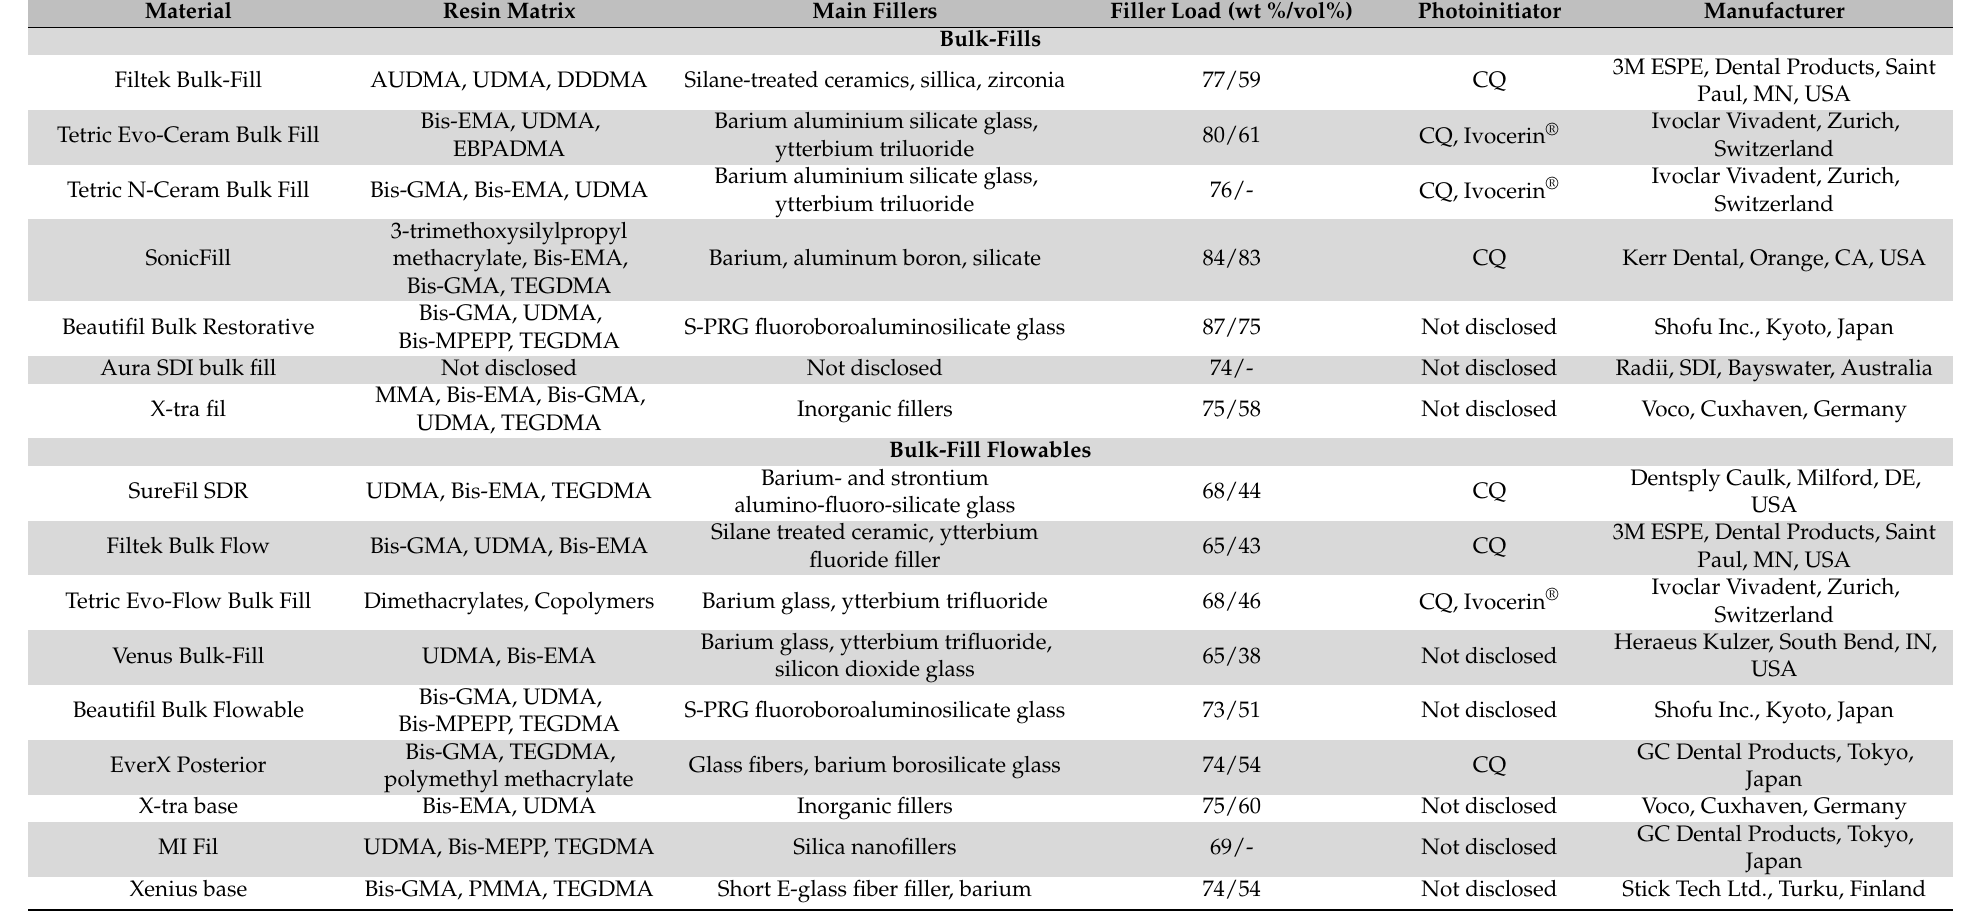
Table 2. Summary of bulk-fill resin composite materials found in the cited